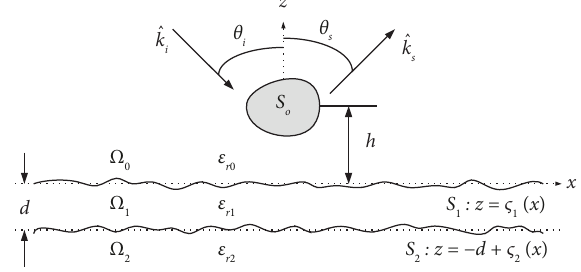
Figure 1: Te geometry of a PEC object above a two-layered rough